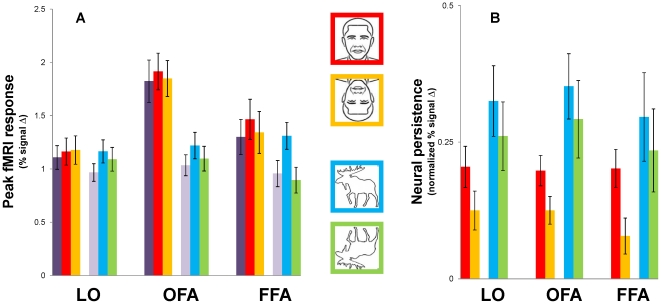
Face-selectivity and persistence-related fMRI activity.(A) Peak fMRI responses to faces were higher in face-selective OFA and FFA as compared to object-selective LO; to a lesser degree, upright faces and animals showed higher peak fMRI responses than their inverted counterparts in the OFA and FFA but not LO. (B) Neural persistence was computed by subtracting fMRI responses to Persist trials from Vanish trials, matched by category, for the period indicated by the shaded area in Figure 4. Neural persistence was higher for upright faces and animals than their inverted counterparts, in all ROIs, even after similar differences in the peak (B) were taken into account. This pattern of results (B) was found in all three ROIs and closely resembles that observed in the behavioral results shown in Figure 2. Error bars show the standard error (SE) for the group (n = 12).